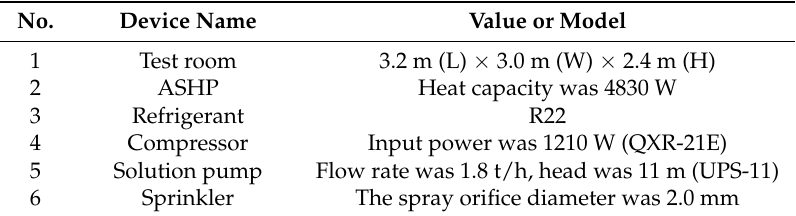
Table 4. Parameters of main devices [79].